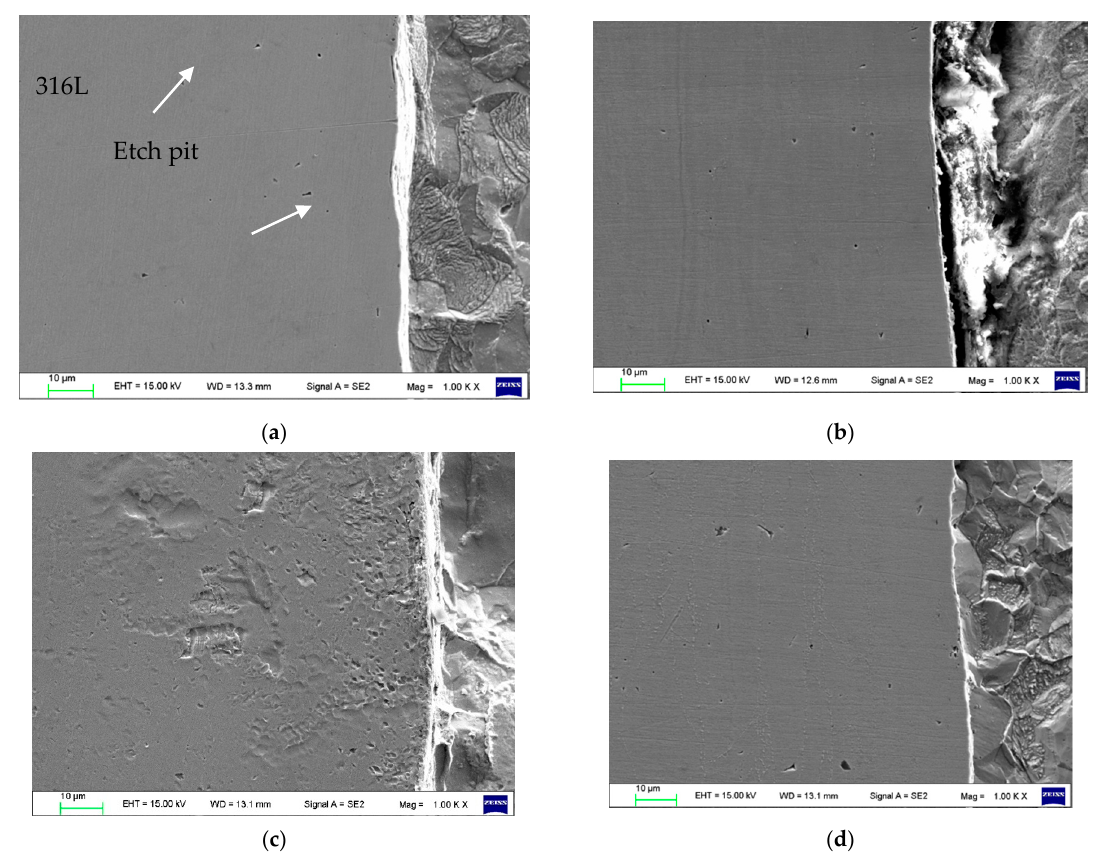
◦ C; ( b ) 600 ◦ C; ( c ) 800 ◦ C; ( d ) 1000 ◦